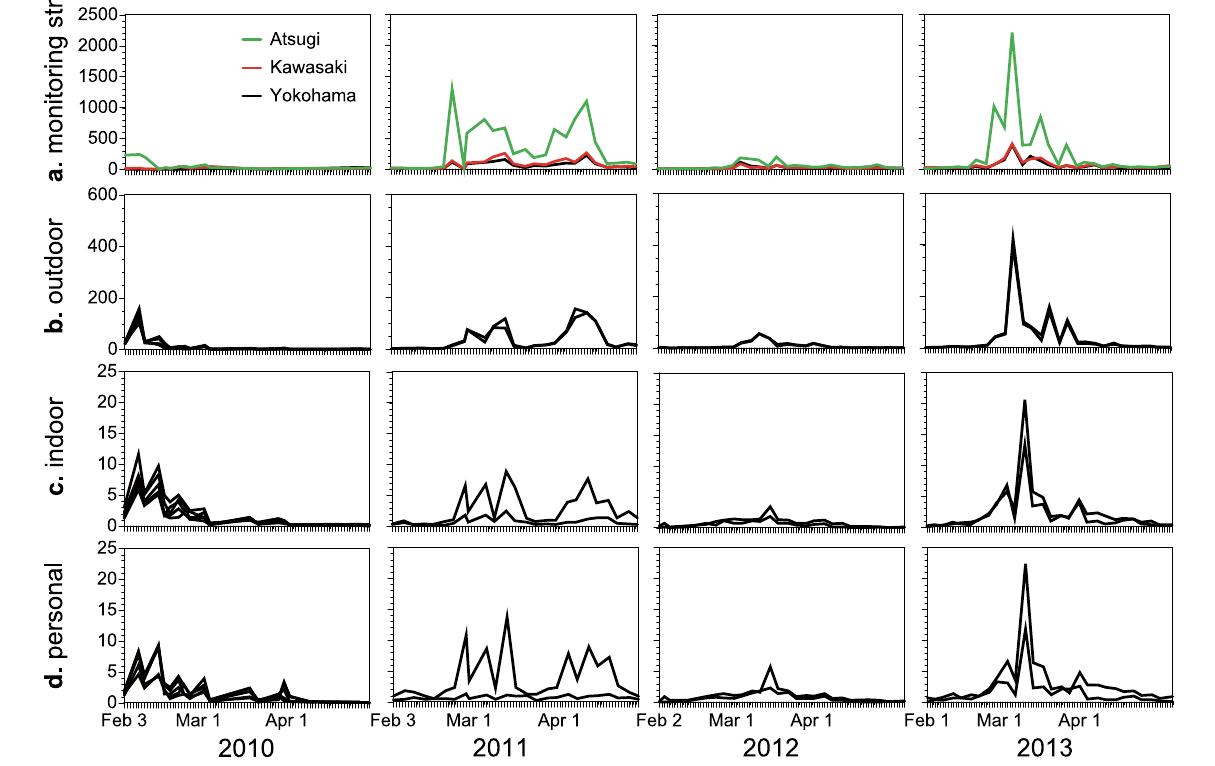
Fig 3. Airborne pollen concentrations and counts during the study periods. Ambient pollen concentrations (pollens m -3 ) were monitored at the three stationary monitoring stations of the Japanese government (a). Outdoor (b), indoor (c), and personal (d) pollen counts (pollens cm -2 day -1 ) were measured for each subject in Isehara. Each black line represents data for each subject.